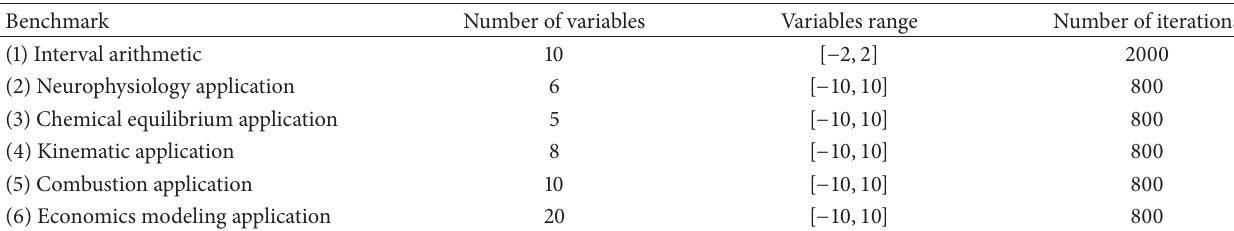
Table 3: Benchmarks used in the experiments.